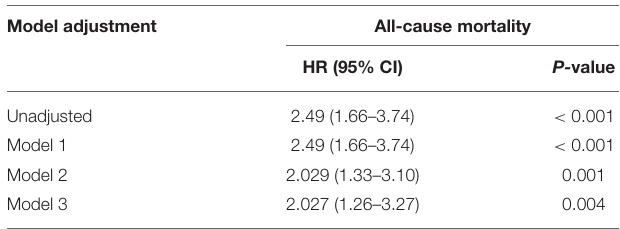
TABLE 3 | Adjusted hazard ratios of all-cause mortality by high CHA2DS2-VASc score ( ≥ 6 points) relative to low CHA2DS2-VASc score ( < 6 points). Model